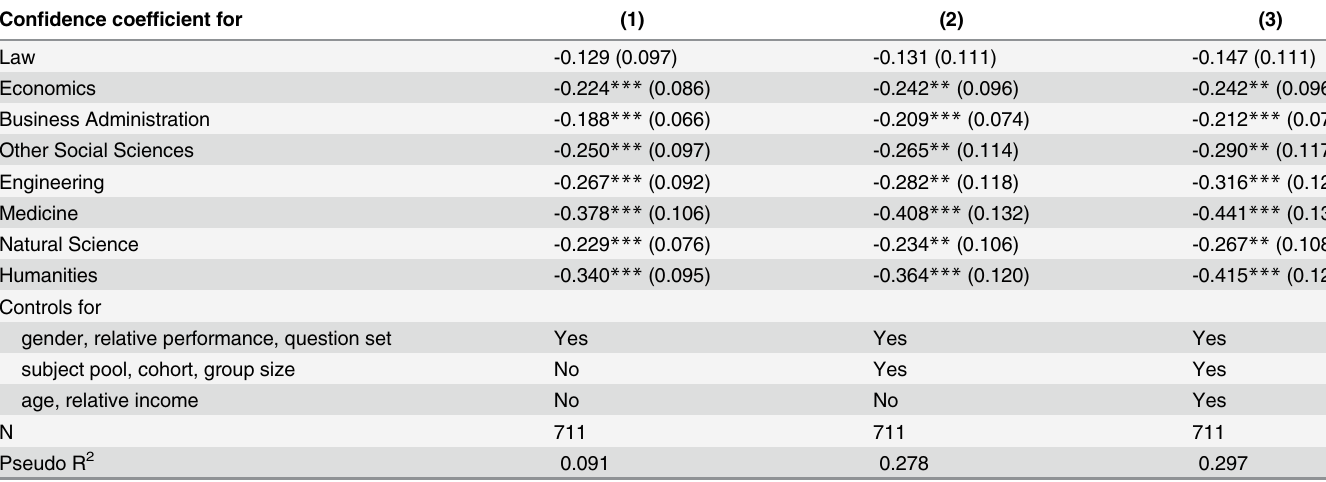
Table 1. Field of study and